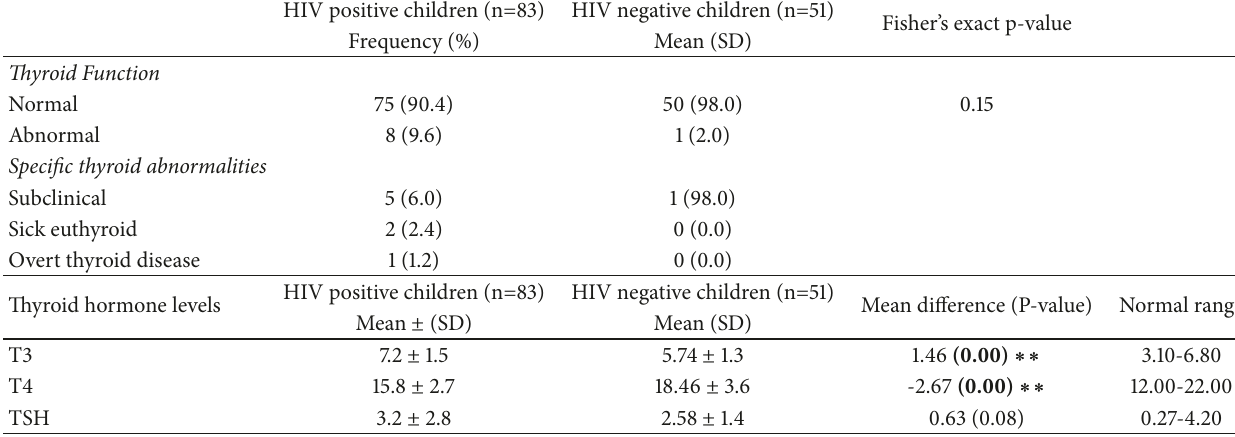
Table 3: Thyroid function values for the study participants.